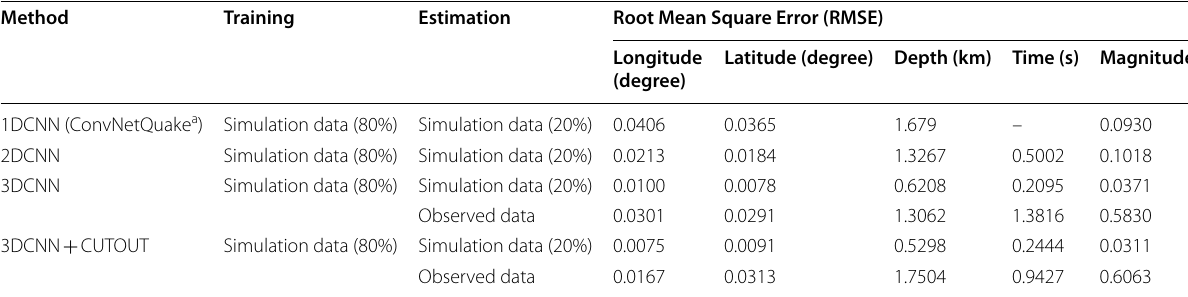
a ConvNetQuake (Perol et al. 2018) is a task to classify earthquake location into specific regions. The results show in this table for ConvNetQuake is obtained by added our task to perform regression to locate hypocentral parameters during the learning stage